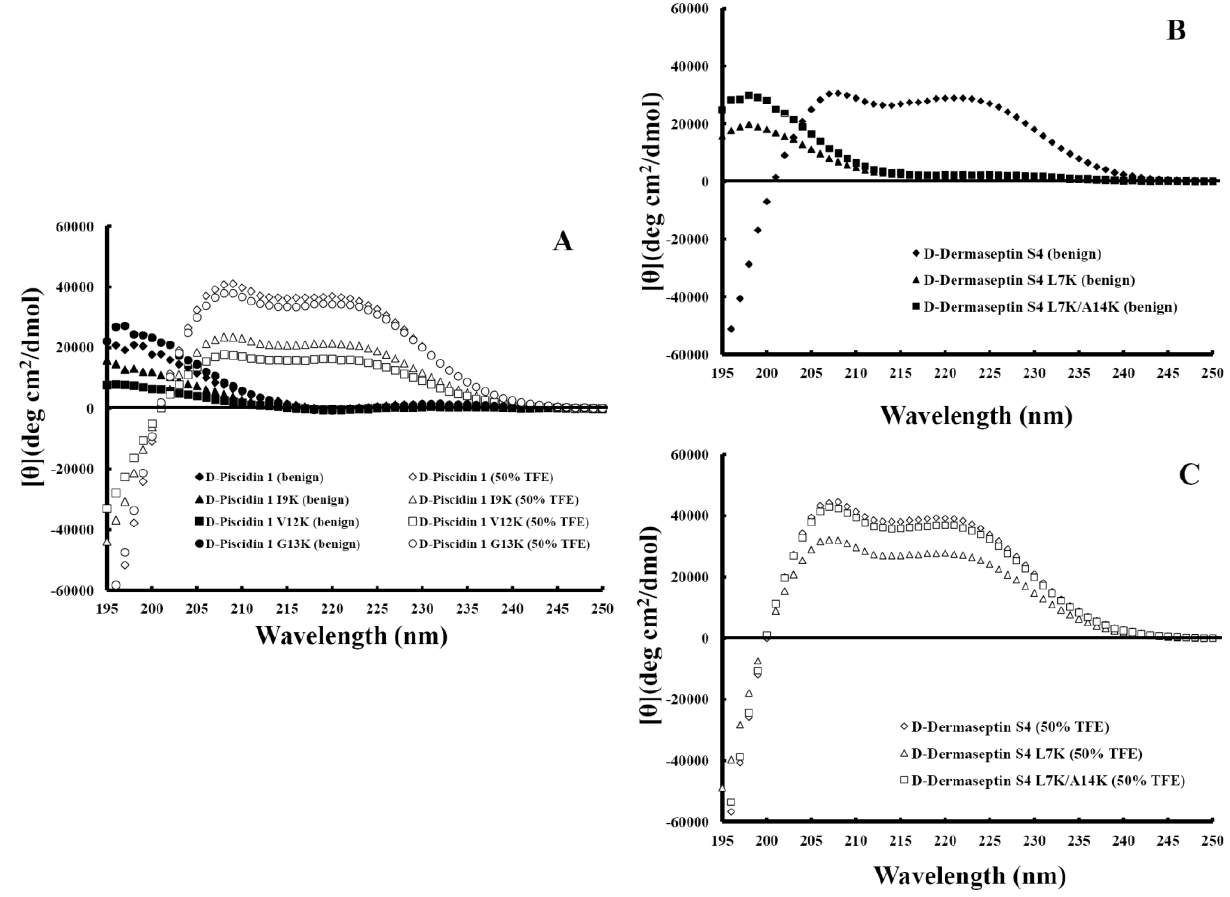
Figure 4. Panel A shows the CD spectra of D -pisicidin 1 analogs in aqueous benign buffer (100 mM KCl, 50 mM NaH PO /Na HPO at pH 7.0), 5 °C (closed symbols) and in the 2 4 2 4 presence of buffer-trifluoroethanol (TFE) (1:1, v / v ) (open symbols). Panel B shows the CD spectra of D -dermaseptin S4 analogs in aqueous benign buffer (100 mM KCl, 50 mM NaH PO /Na HPO at pH 7.0), 5 °C and panel C shows D -dermaseptin S4 analogs in the 2 4 2 4 presence of buffer-trifluoroethanol (TFE) (1:1, v / v